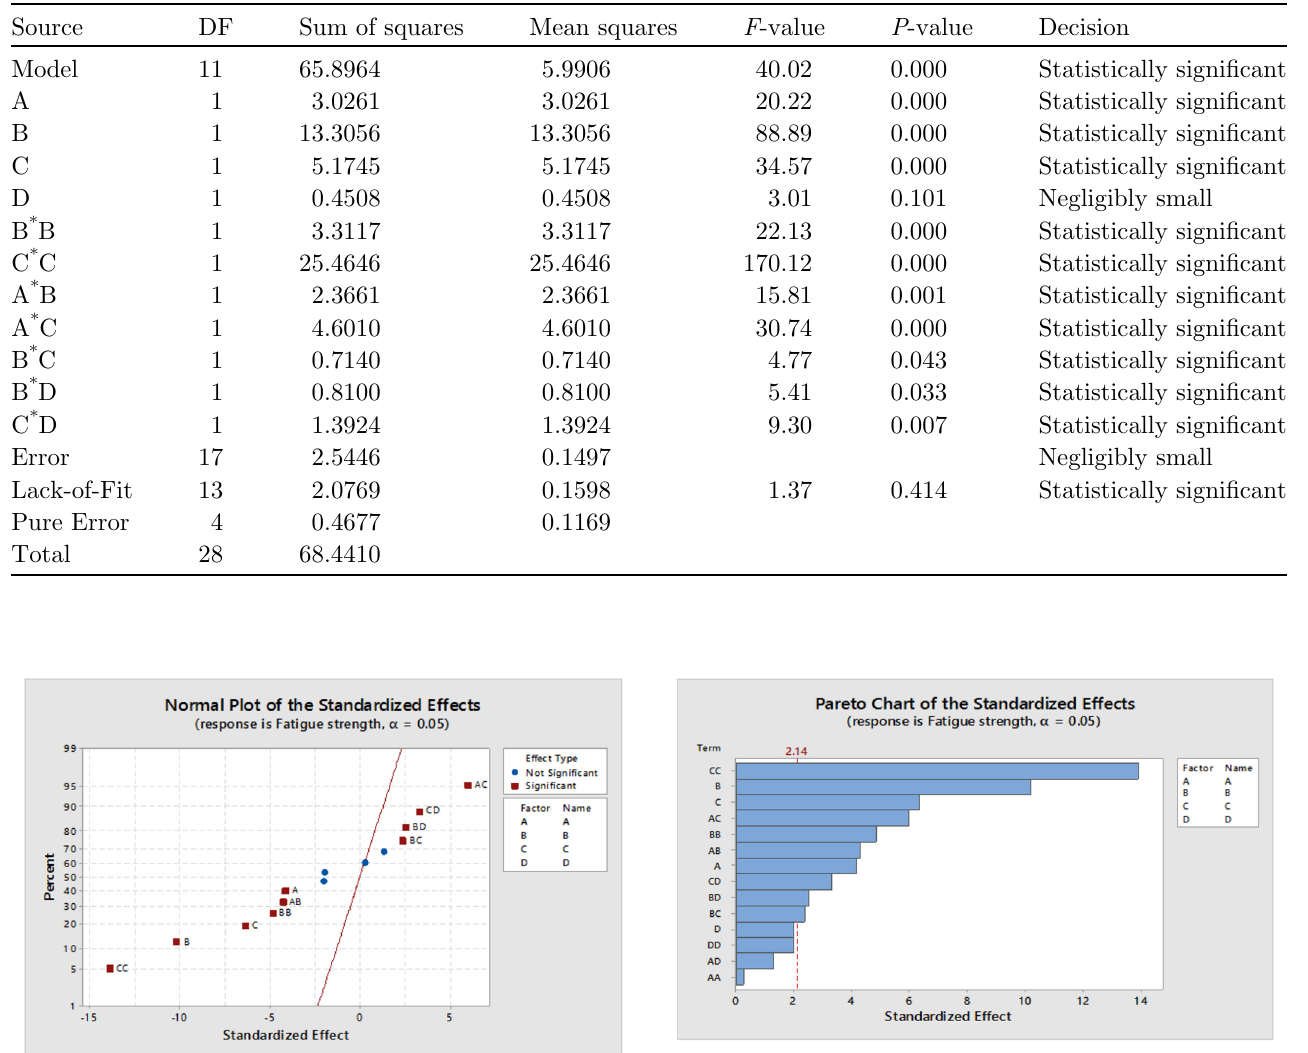
Table 5. Final ANOVA for fatigue strength.